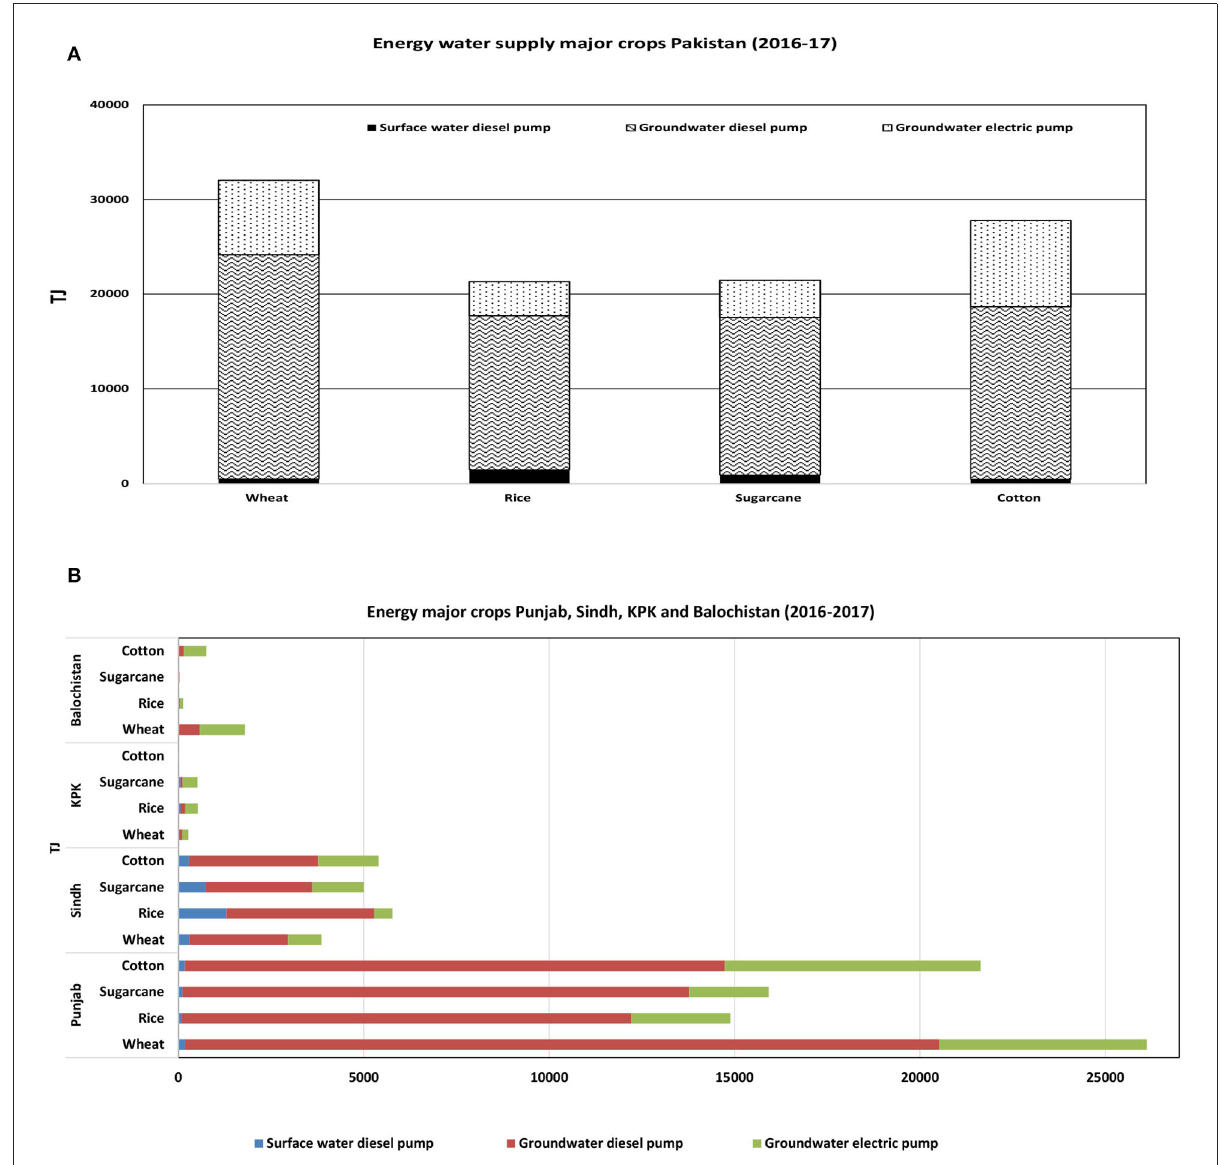
FIGURE4 (A) Energy footprint irrigation of major crops (wheat, rice, sugarcane, and cotton) in Pakistan (2016–2017). (B) Energy footprint irrigation of major crops (wheat, rice, sugarcane, and cotton) in Punjab, Sindh, KPK, and Balochistan in